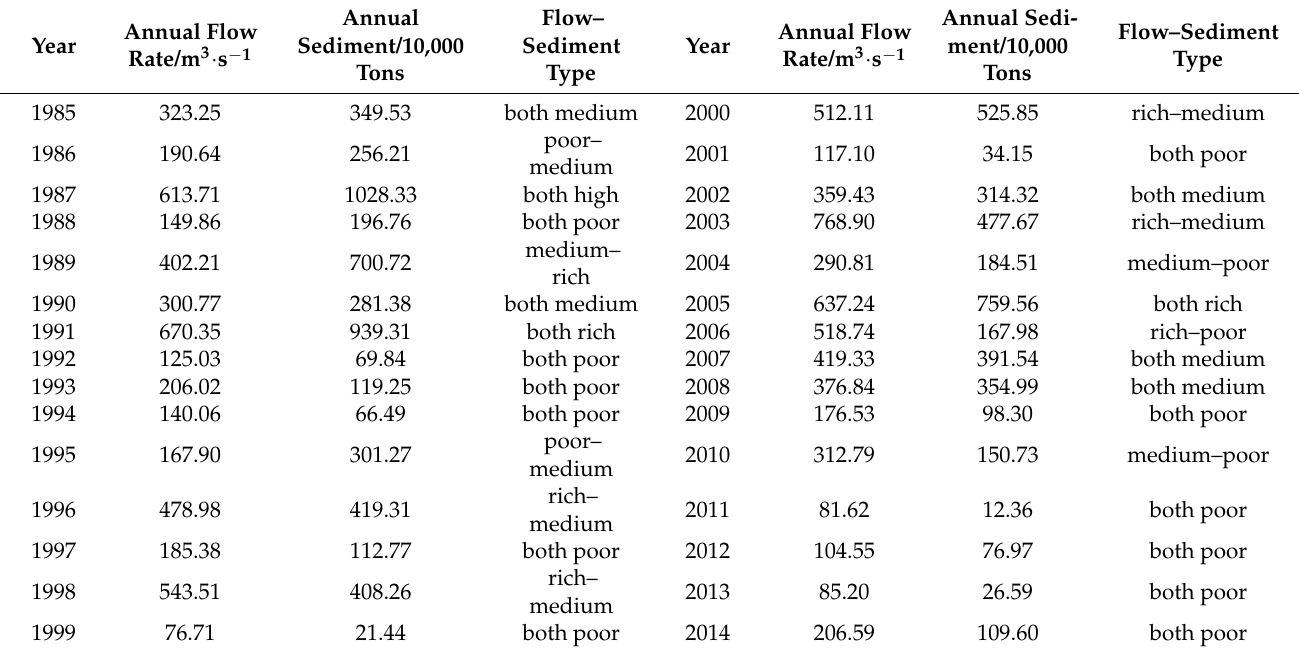
Table 1. The flow and sediment at Wanglin section from